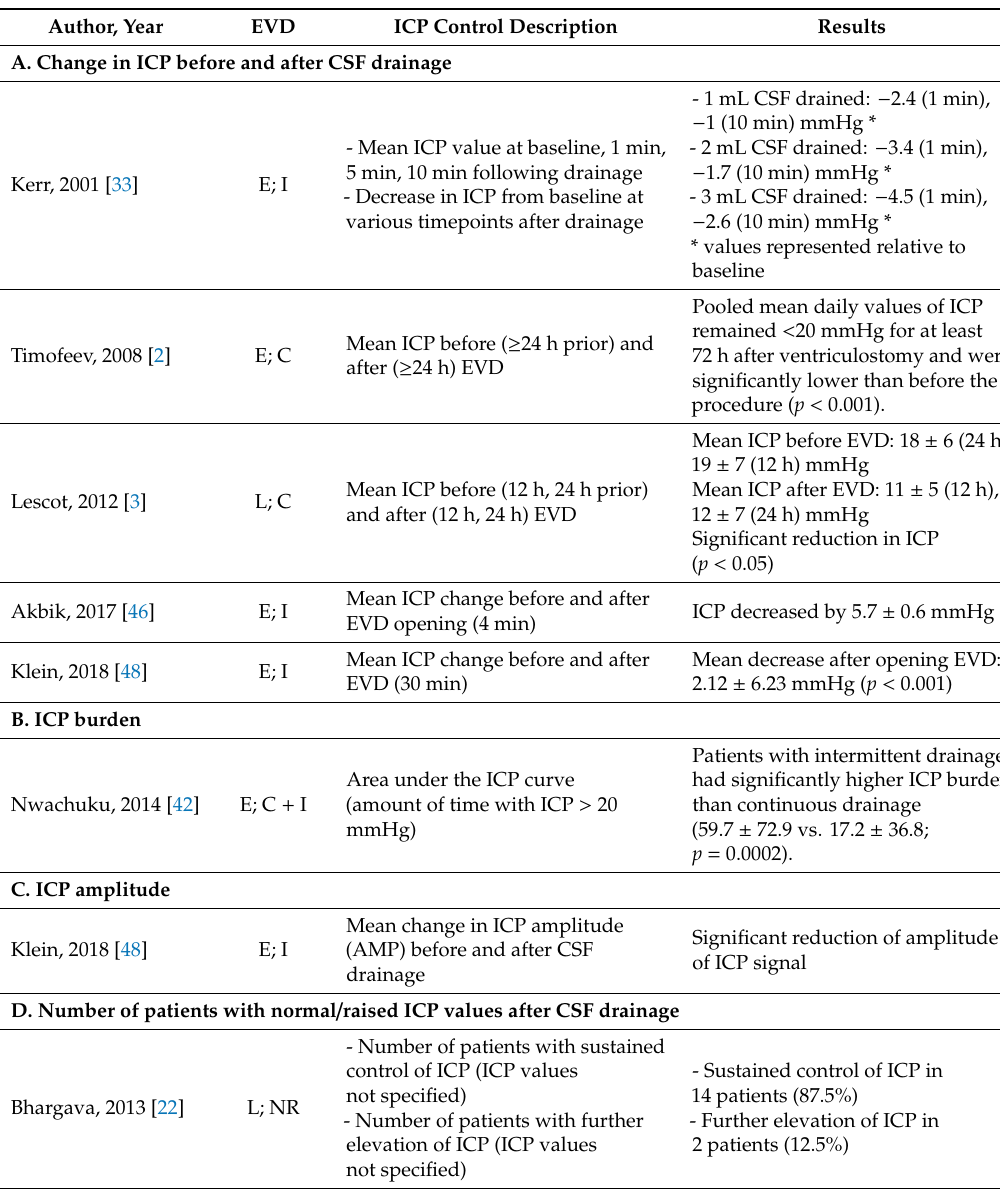
Table 4. Four definitions of ICP control used in the seven studies that investigated the e ff ectiveness of CSF drainage on ICP